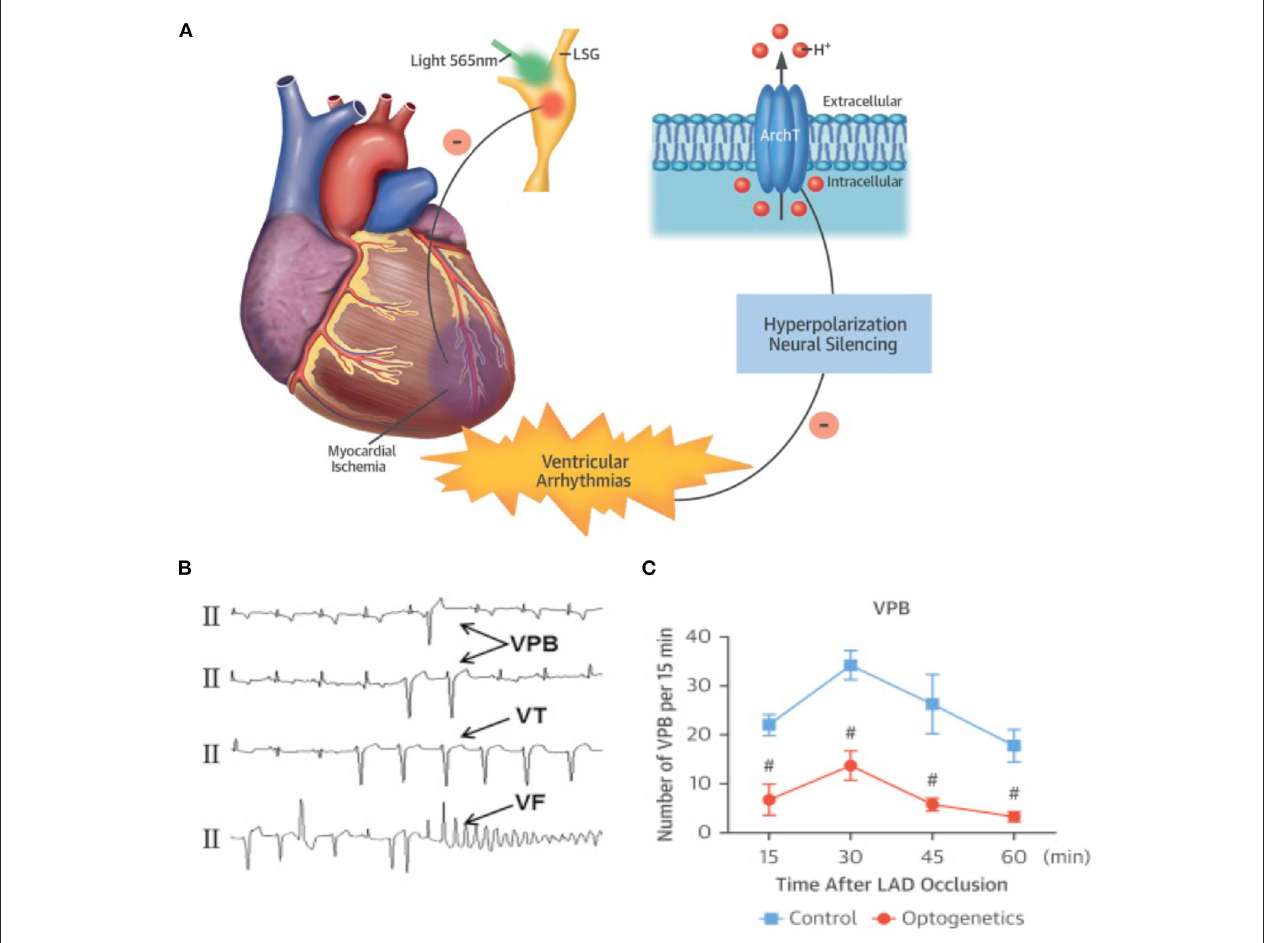
FIGURE 9 | Optogenetic-based interruption of cardiac arrhythmias. (A) Schematic representation of the potential role of neuronal optogenetics in stopping ventricular arrhythmias. Photostimulation of ArchT with 565nm light inhibits SNs, leading to significant decrease in arrhythmic events after myocardial ischemia. (B) Representative examples of ischemia-induced ventricular arrhythmias (Vas). (C) Quantitative analysis of the incidence of ischemia-induced VAs showed that optogenetic modulation significantly decreased the number of ventricular premature beats (VPBs). (A–C) Modified with permission from Yu et al. (2017)